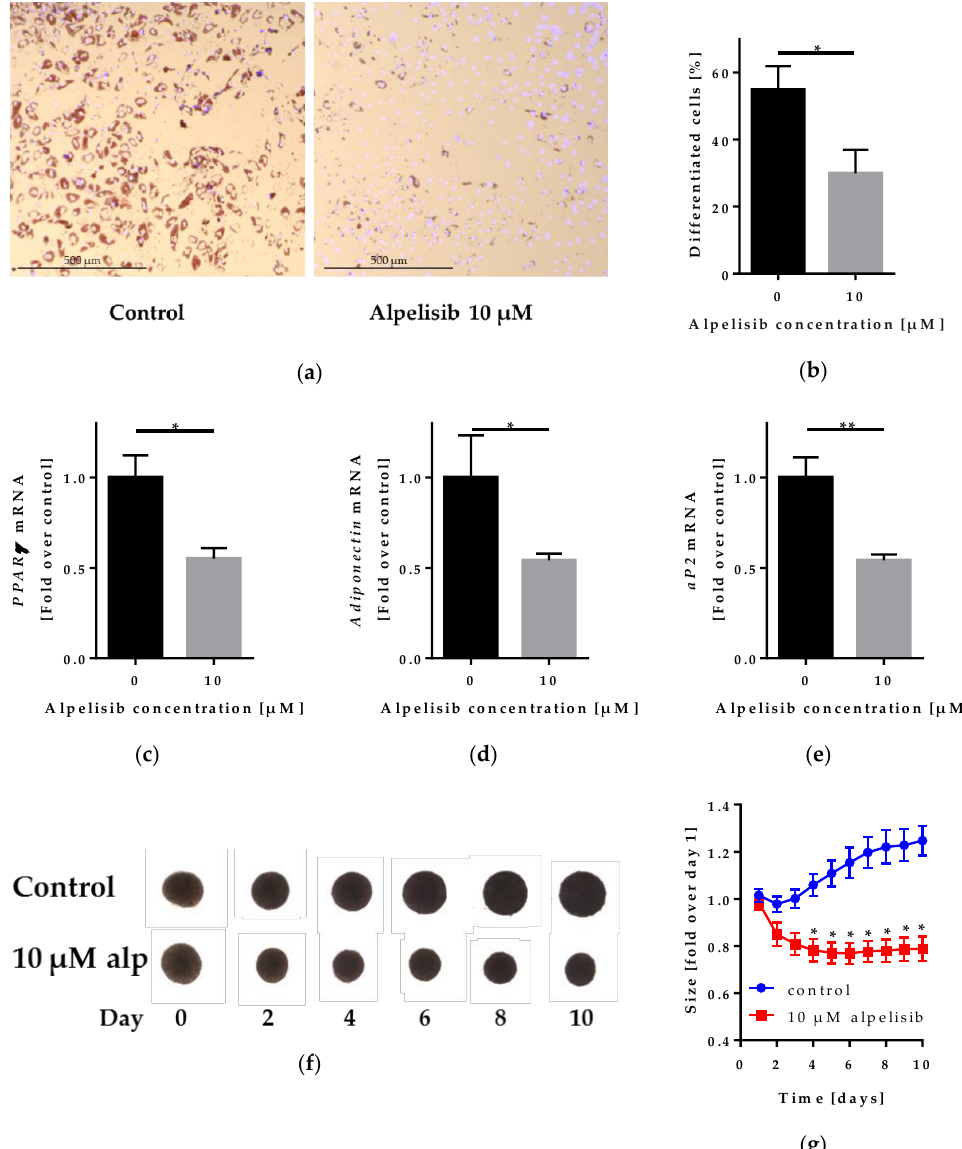
Figure 6. Alpelisib treatment of LipPD1 cells during adipocyte differentiation: ( a ) Oil Red O lipid (red) and Hoechst (blue) staining after 10 days in differentiation medium showed reduced lipid accumulation after 10 µM alpelisib treatment; ( b ) the percentage of adipocytes after 10 days in differentiation medium was decreased with 10 µM alpelisib (alp) compared to solvent control, n = 3, * p = 0.016. RT-qPCR of adipogenesis-related genes in LipPD1 cells after 10 days of differentiation with or without 10 µM alpelisib: mRNA expression of ( c ) PPARγ , ( d ) Adiponectin, and ( e ) aP2 was downregulated in 10 µM alpelisib-treated cells. Fold over control, values were normalized to the housekeeper gene β -actin , n = 3, * p ≤ 0.05, ** p ≤ 0.01. ( f ) 10 µM alpelisib treatment of 3D LipPD1 cell cultures during adipocyte differentiation; ( e ) size of 3D lipoma spheroids during 10 days in differentiation medium decreased with 10 µM alpelisib (alp) compared to day 1, values for day 1 were calculated by normalizing to the mean of day 1; for following days, each spheroid size was divided by the size of the same spheroid at day 1, n = 4, * p ≤ 0.05.